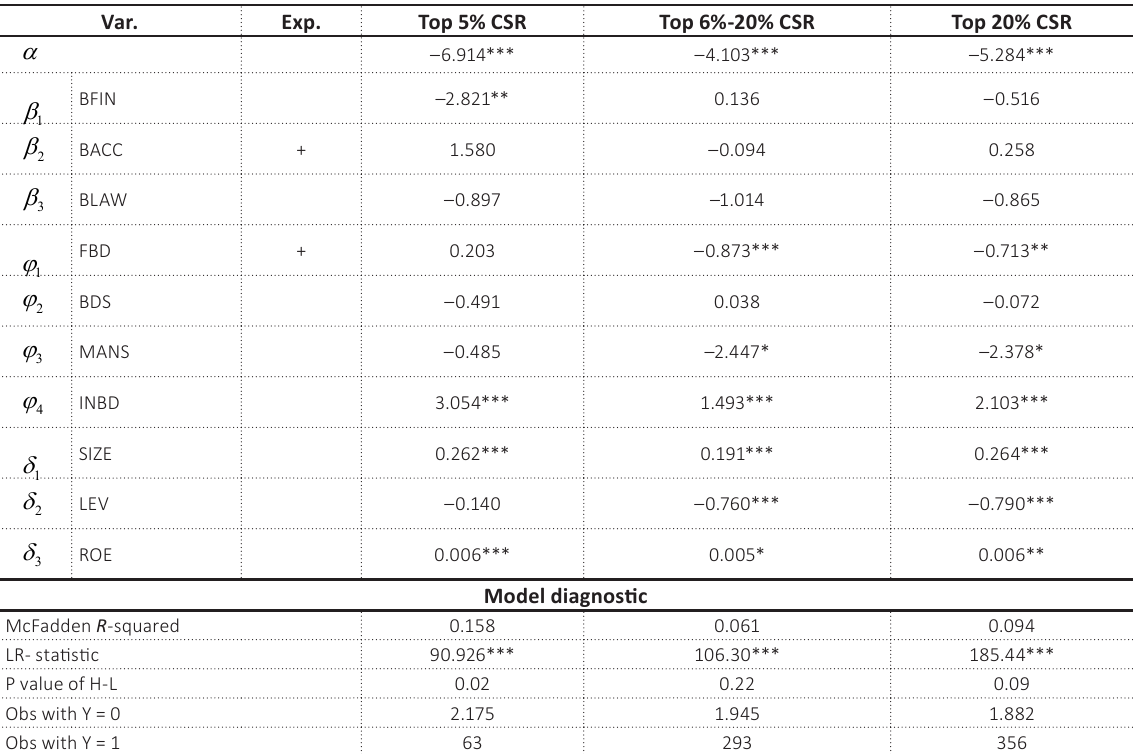
Table 6. The impact of Board gender and Accounting background on CSR (probit regression analysis for the case of 7-8 board